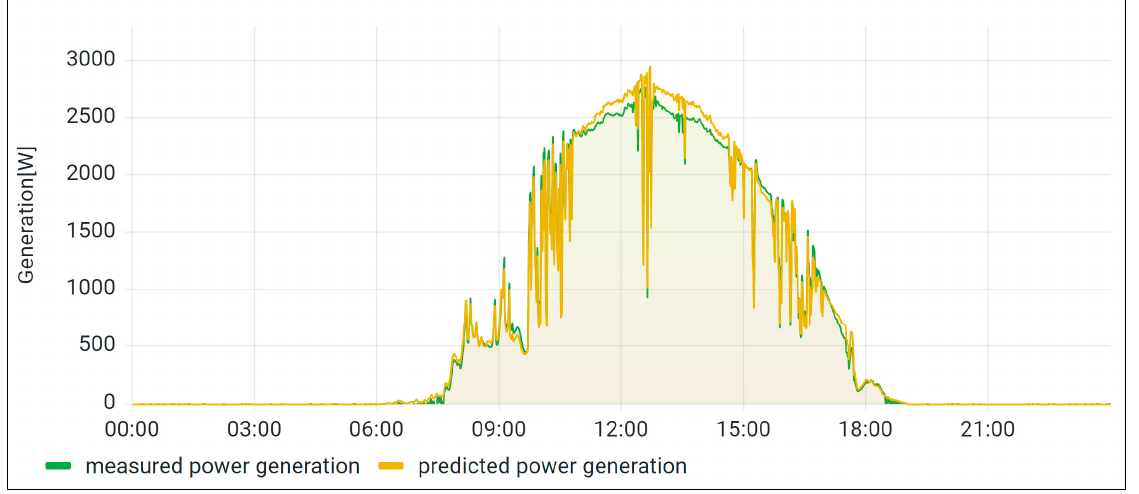
Figure 7. Predicted and measured power generation in normal operation.